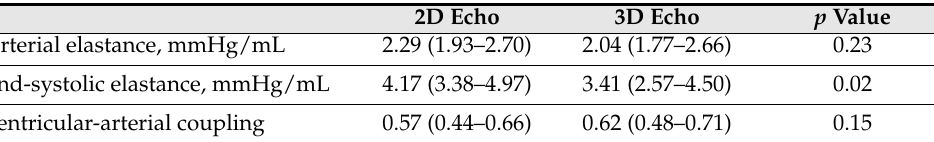
Table 6. Arterial elastance, End-systolic elastance and Ventricular-arterial coupling by 2D and 3D echocardiography ( n = 65).